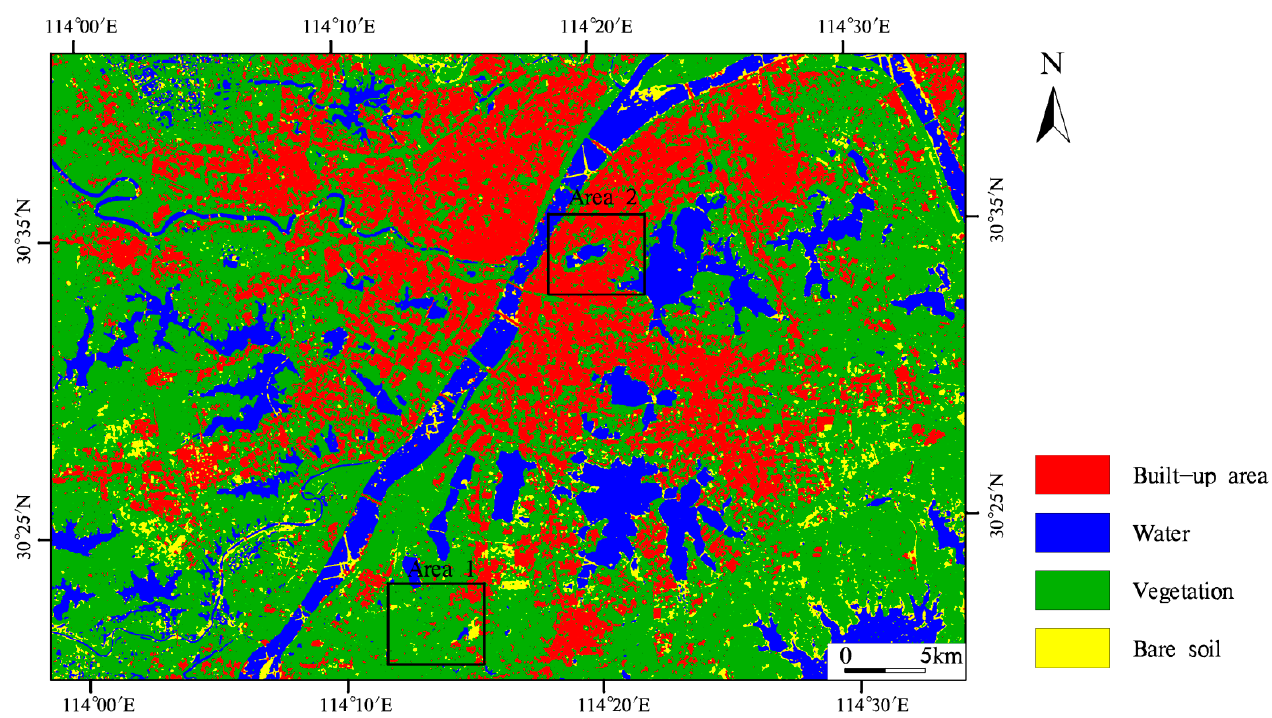
Figure 10. Land cover map obtained from the SVM-CK algorithm with the Sentinel-1A SAR image.